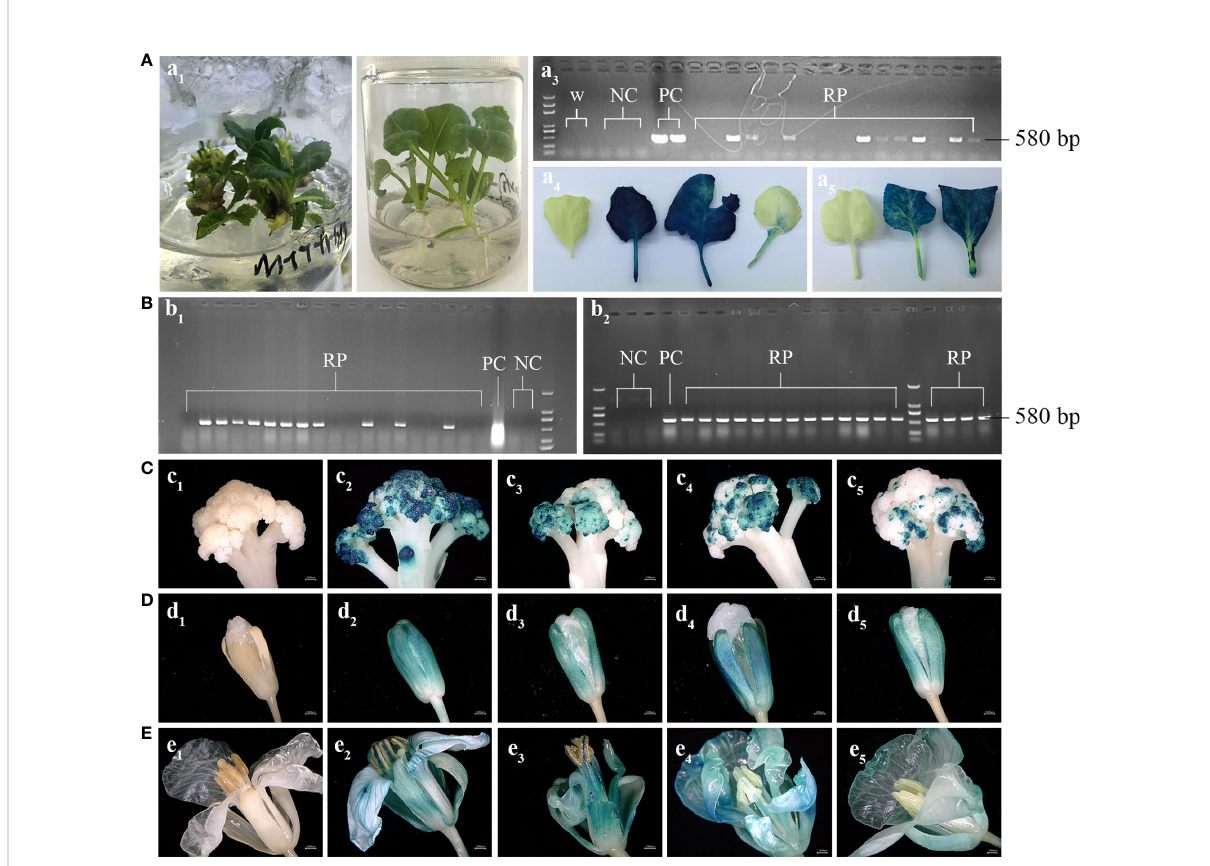
FIGURE 3 PCR analysis and histochemical GUS staining of transgenic plants at the stages of aseptic seedlings (A) and fl owering after transplanted into soil condition in greenhouse (B – E) . (A1) hygromycin resistant shoots, (A2) hygromycin resistant plants regenerated adventitious roots, a3, PCR analysis of transgenic plants using a pair of speci fi c primers for HPT gene and a target band of 580 bp was ampli fi ed from the positive plants. Histochemical GUS staining for the leaves of transgenic seedlings and those with blue spots were positive plants (A4, A5). (B1) and (B2), the positive plants of cauli fl ower (B1) and broccoli (B2) identi fi ed at seedling stage were transplanted into the soil for the second round of PCR analysis. The second round of histochemical GUS staining analysis of cauli fl ower curd (C1, negative control, (C2-5) transgenic plants) and broccoli fl owers (D1 and C1, negative control, D2-5 and E2-5, transgenic plants). w, water. NC, negative control. PC, positive control. RP, regenerated hygromycin resistant